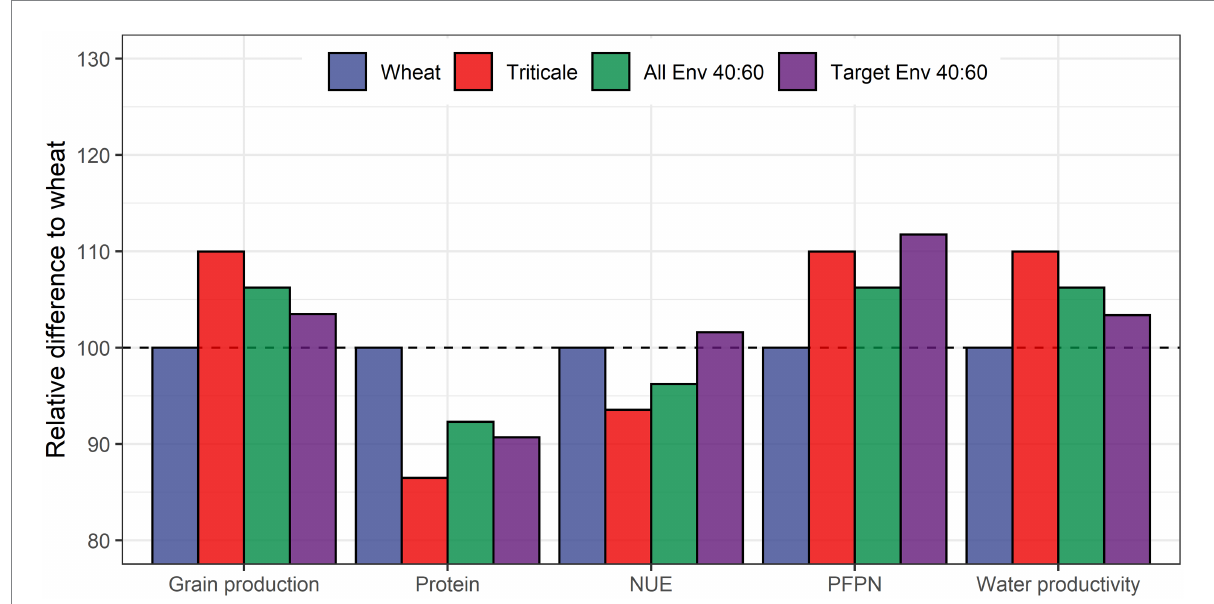
FIGURE 4 Graphical representation of relative values in Table 3 comparing grain production, protein concentration, and productivity metrics to a baseline of 100% wheat (blue bars) or triticale (red bars) production compared to a 40:60 (green bars) and 40:60 (purple bars) for all and targeted environments, respectively.